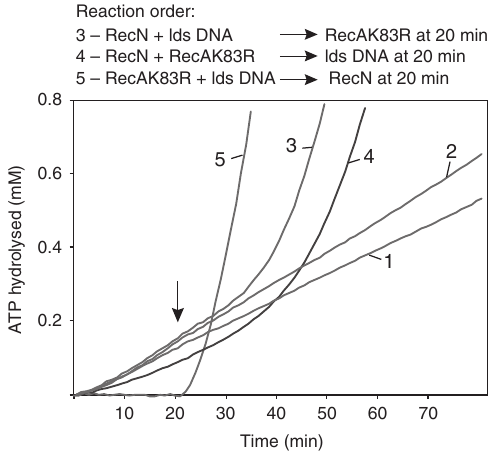
Figure 4 | RecA protein stimulates the DNA-dependent rate of RecN ATP hydrolysis. ATPase reactions were carried out as described in the Methods section. The ATP hydrolysis measured reflects only that catalysed by RecN protein since RecA K83R is a ATPase-deficient RecA mutant. Linearized pEAW324 plasmid DNA is utilized where indicated. Reactions 1 and 2 are control experiments measuring the amount of ATP hydrolysis over time by RecN protein (2 m M) in the absence (reaction 1) or presence of 50 m M DNA (reaction 2). The order of addition for reactions 3, 4 and 5 are shown (top). The first set (reaction 3, RecN and DNA; reaction 4, RecN and RecA K83R; and reaction 5, RecA K83R and DNA) were incubated with 2.5mM ATP in buffer N (see Methods) for 20min before the second addition (reaction 3, RecA K83R; reaction 4, DNA; and reaction 5, RecN). The time of the second addition is indicated by a vertical arrow. The final concentration of RecN, RecA K83R and DNA was 2, 2 and 50 m M, respectively. See Table 1 for steady-state rates of RecN ATP hydrolysis and lag times.